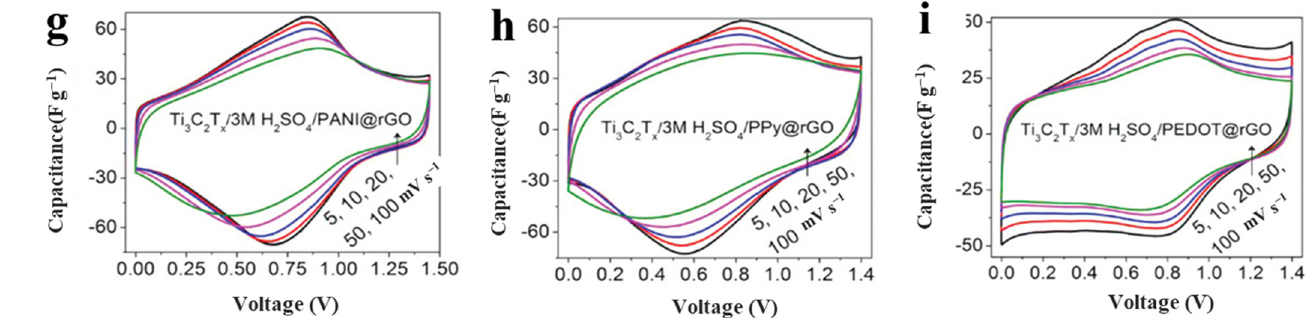
Figure 18. ( a ) An exemplification of MXene synthesis, ( b ) schematic illustration of the tests, ( c ) cross- sectional image and the ( d – i ) CV curve of the MXene-based electrodes [135].